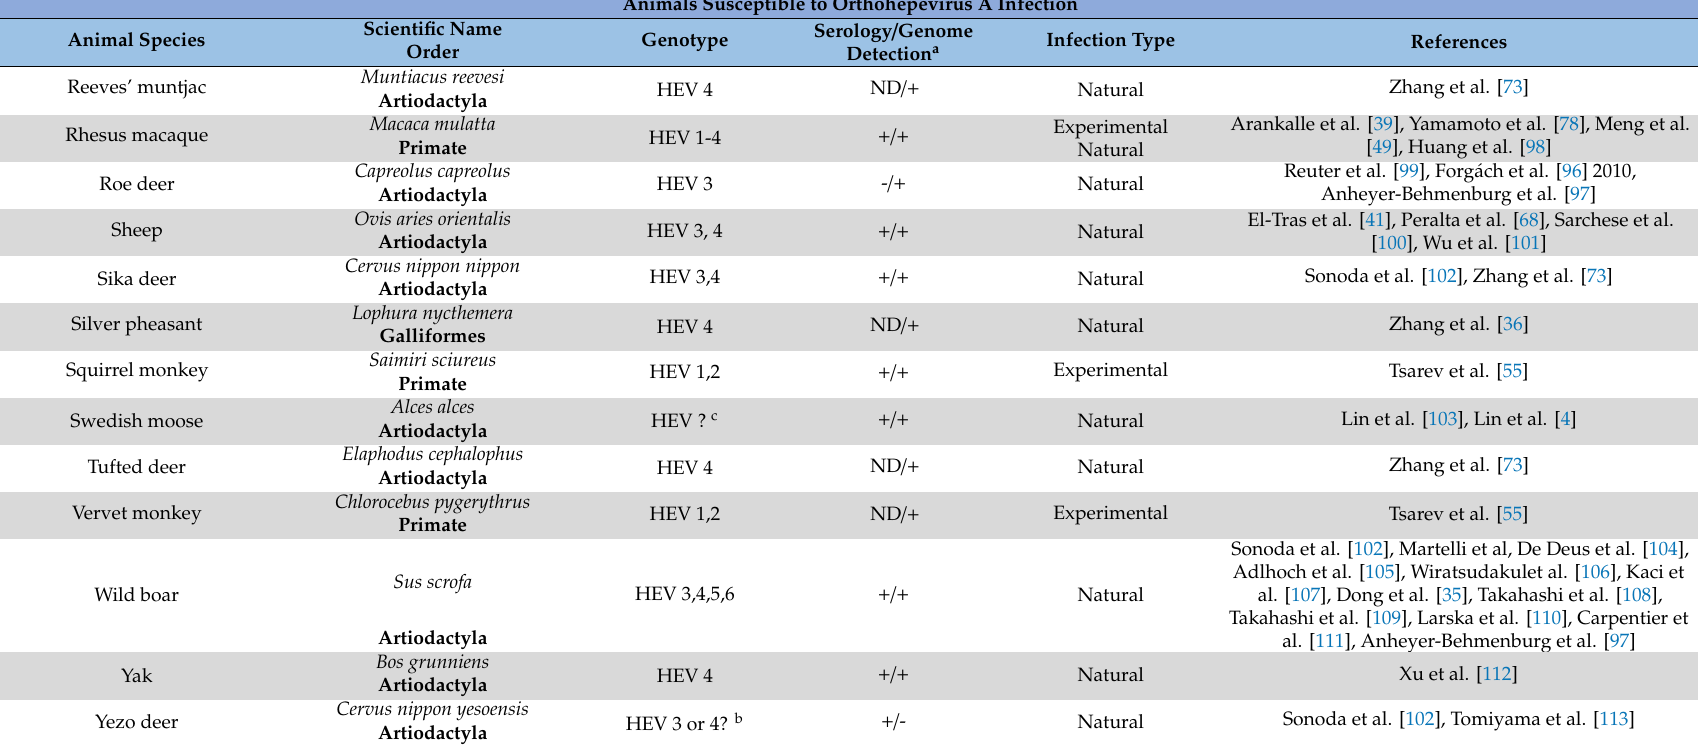
Table 1. Animals known to be associated with Orthohepevirus A infection. Text in bold indicates taxonomic order. For serology / genome detection “ + ” is any reported positive result, “-“ indicates assays were performed and results were negative, “ND indicates test was not performed (Not Done).” a Serology and genomic RNA detection are a summary of all published data. Individual articles may have only included serology, only genomic RNA detection, or both. b Data presented as only serological data suggest animals were exposed to HEV but a definitive strain could not be assigned due to the single serotype of all HEV strains. c Swedish moose HEV strain has not been assigned to a current HEV genotype and appears to cluster between Orthohepevirus A and Orthohepevirus C